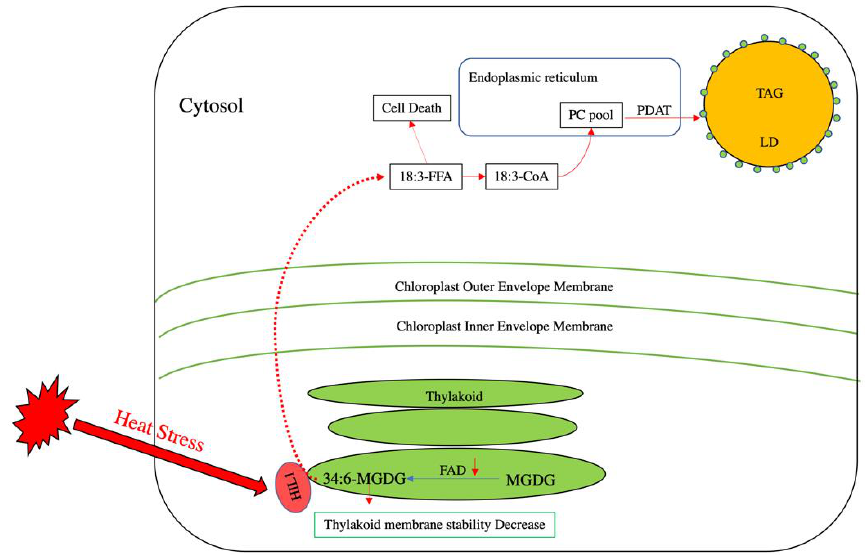
Figure 2. Lipid remodeling in Arabidopsis under heat stress. In thylakoid membranes, monogalactosyldiacylglycerol (MGDG) and fatty acid desaturase (FAD) introduce double bonds into MGDG to yield 34:6-MGDG. Under heat stress, polyunsaturated fatty acid-enriched MGDG can decrease thylakoid membrane stability. The activity of some FADs decreases to reduce the production of 34:6-MGDG. Concomitantly, a putative thylakoid-localized lipase termed heat-induced lipase 1